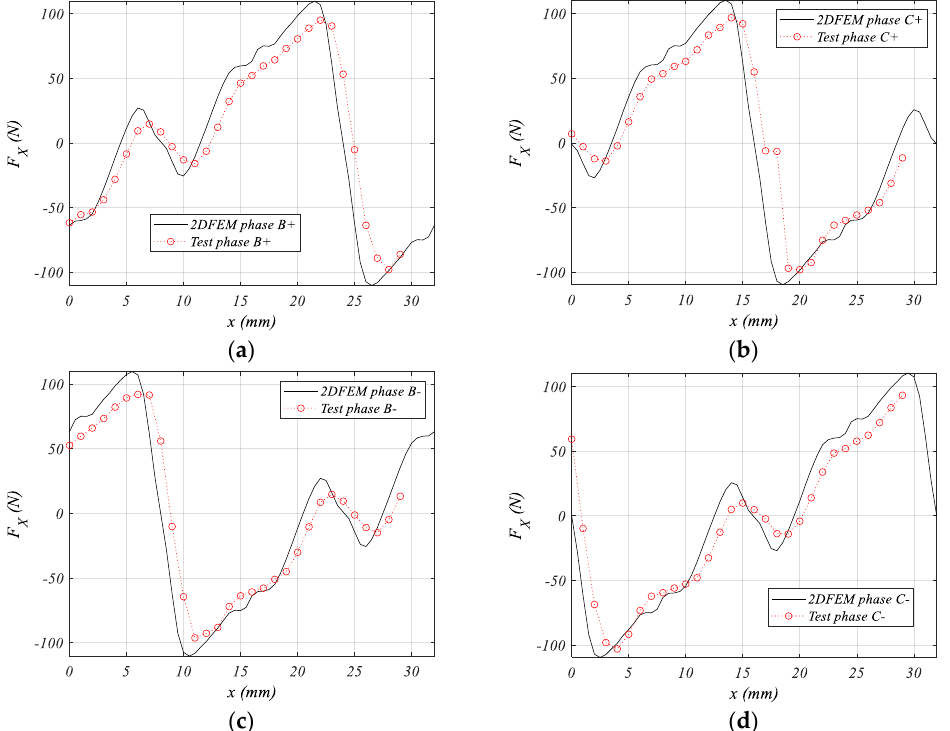
Figure 13. Propulsion force comparison results for J = 10 A/mm 2 , shift = 0 mm ( a ). Phase I B = 3.12A. ( b ) Phase I C = 3.12A. ( c ) Phase I B = −3.12A. ( d ) Phase I C = −3.12A.